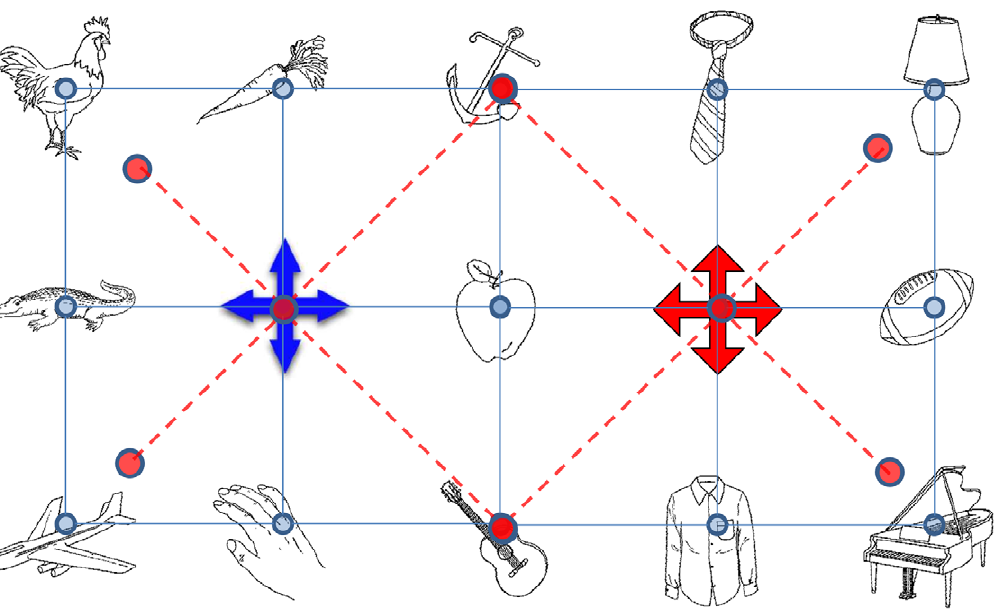
Figure 6. Segmentation and distortion of psychological space described by reaction times. Reaction times in recalling spatial relations of object pairs are not proportional to the distances in the physical space. The relative lengths of the dotted lines represent the comparison of reaction times when the object is associated with a single landmark (group 2 in Figure 4) and when the object can be associated with two landmarks (group 1 in Figure 4), with the latter as the base length.